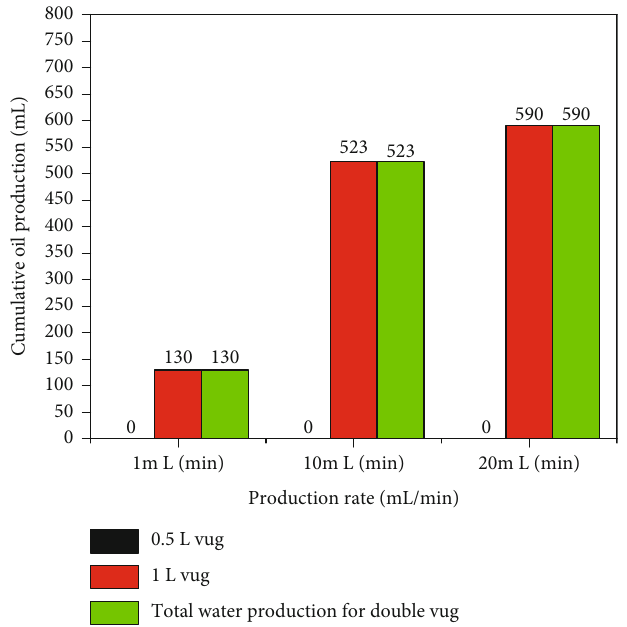
Figure 16: Column chart of cumulative water production in high-pressure physical property experiments under connection type I (di ff erent production rates).